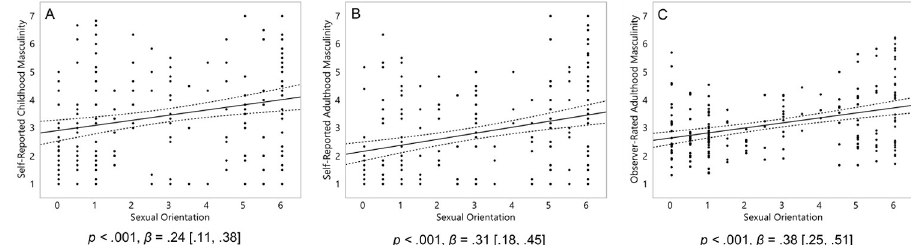
Fig 1. Masculinity of 196 women (self-report from childhood, A; and adulthood, B) and 191 women (observer- ratings, C). On the Y axis, masculinity scores, with higher scores representing a greater degree of masculinity. On the X axis, 0 represents exclusive heterosexuality, 3 represents bisexuality, and 6 represents exclusive homosexuality. Triple lines represent regression coefficients with their 95% confidence intervals. Dots represent participants’ scores. Statistics represent linear effects.